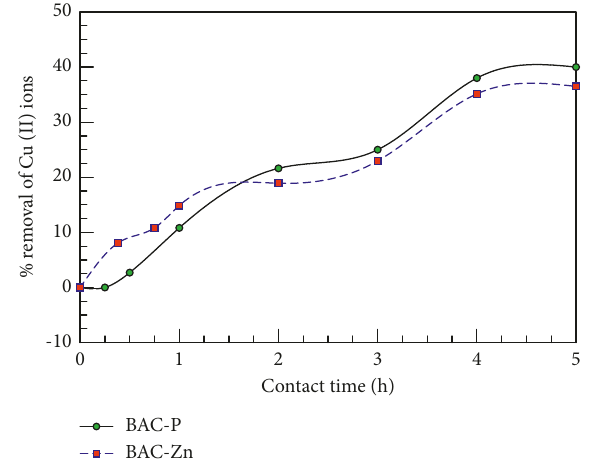
Figure 11: Effect of contact time on the removal efficiency of Cu(II) Figure 12: Effect of adsorbent dosage on the removal efficiency of � 1g L − 1 , pH � 4.5, dose of each ions using BAC-P and BAC-Zn at c Cu(II) ions using BAC-P and BAC-Zn at c 0 adsorbent � 1g, agitation speed � 150rpm, contact time � 300min, agitation speed � 150rpm, contact time � 300min, particle particle size � 250 µ m, and temperature of solution � 30 ° C. size � 250 µ m, and temperature of solution � 30 °